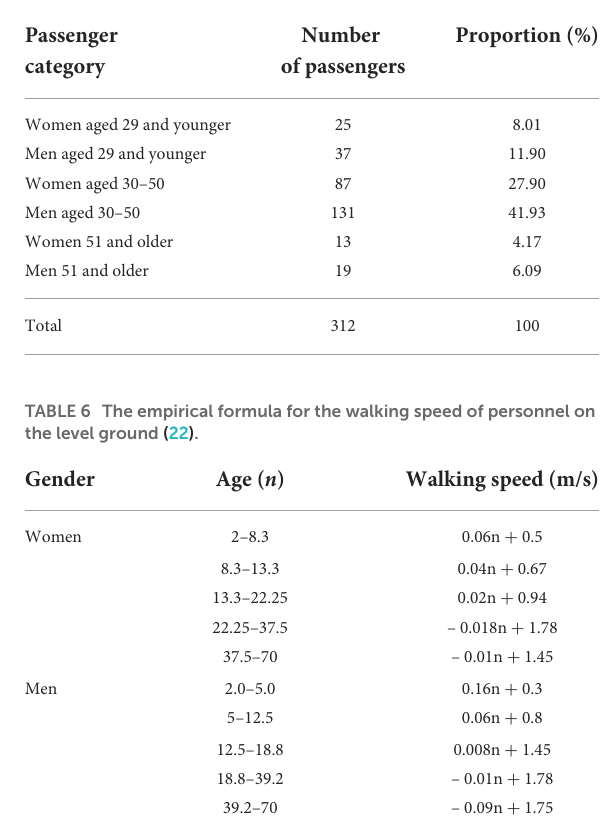
TABLE 5 Age and gender settings of evacuees.